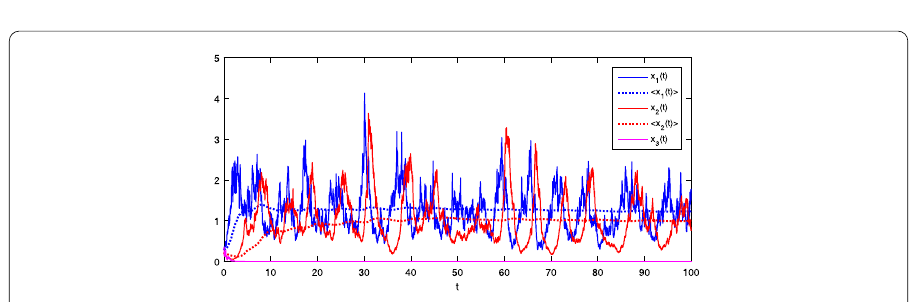
Figure 5 Species x 1 ( t ) and x 2 ( t ) are persistent in the mean while species x 3 ( t ) goes to extinction